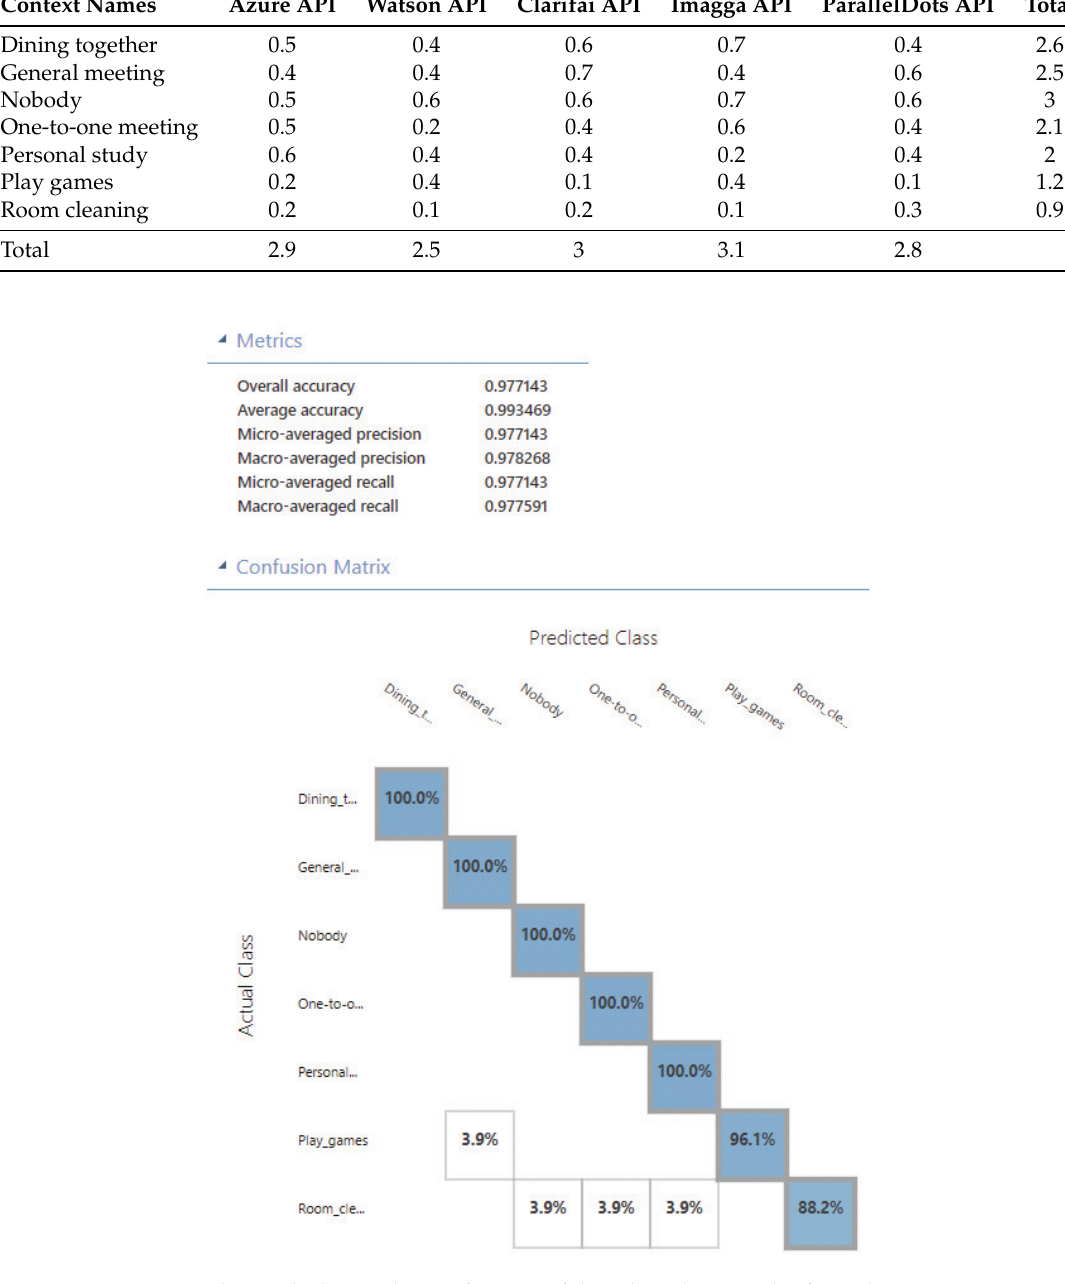
Figure 5. The results by combining features of the selected APIs (Clarifai and